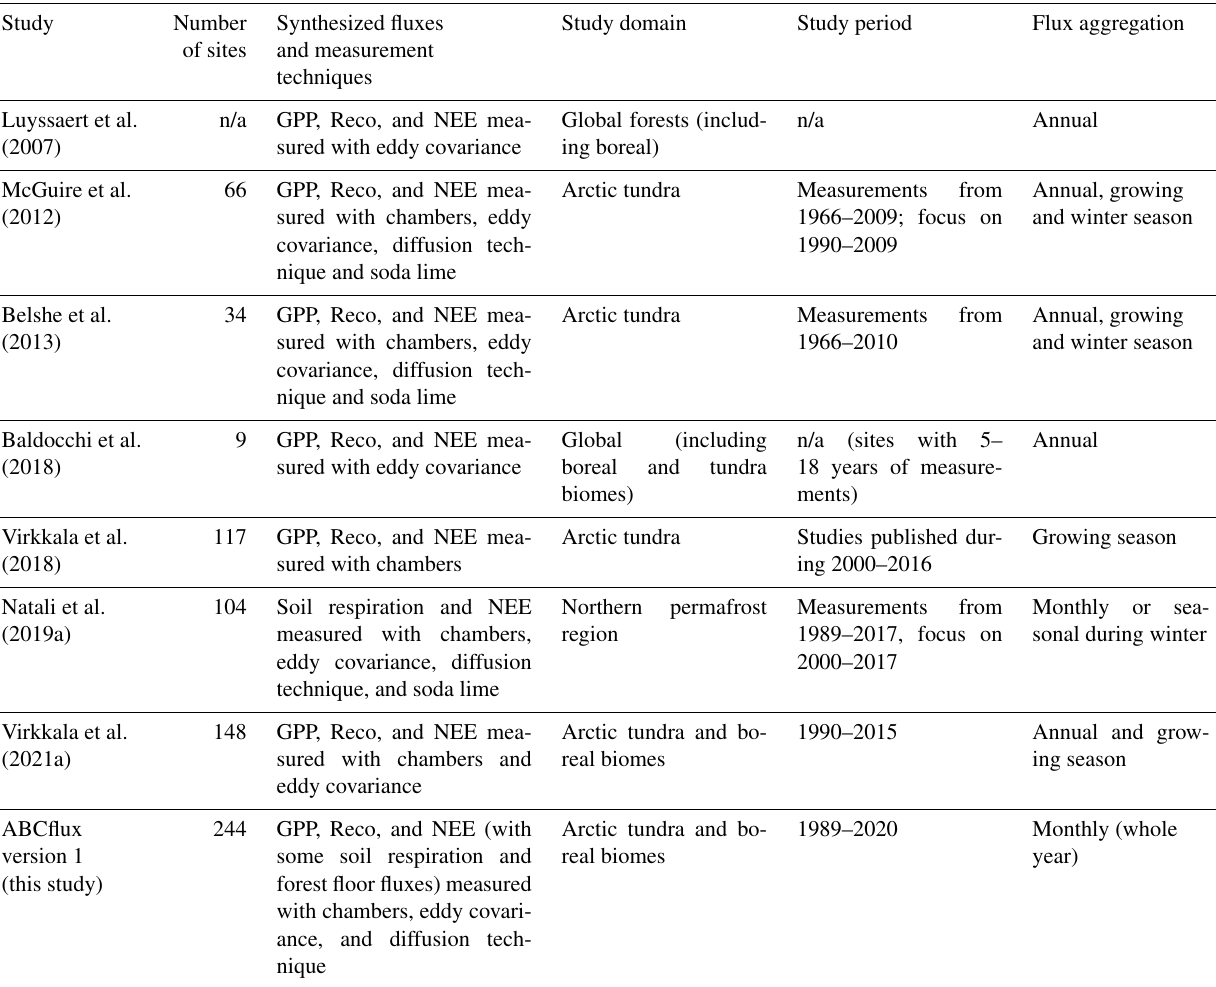
Table 1. A summary of past CO 2 flux synthesis efforts. If site numbers were not provided in the paper, this was calculated as the number of unique sets of coordinates. Note: n/a – not